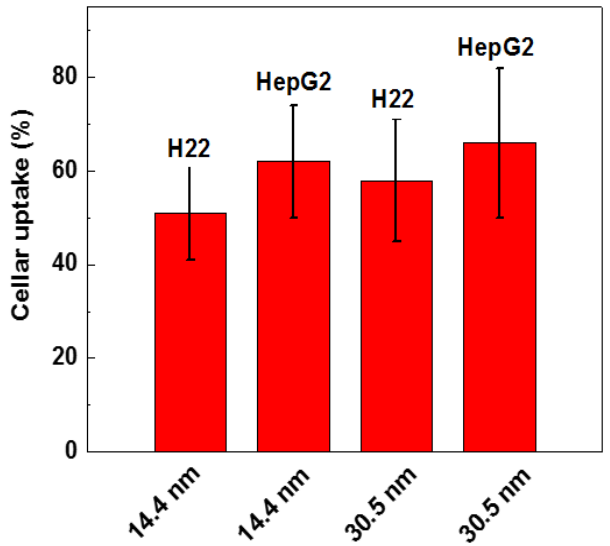
Figure 5. Cellular uptake of 14.4 and 30.5 nm PEG-coated GNPs in H22 and HepG2 cells.